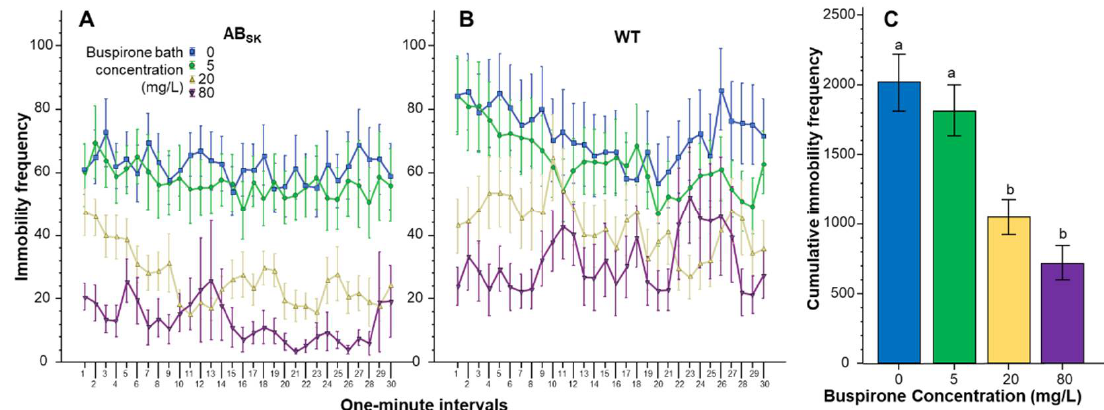
Figure 3. The number of times fish stopped moving (frequency of immobility) is dose dependently reduced by buspirone. Immobility frequency as a function of time (1-min intervals) is shown for ABSK ( A ) and WT ( B ) zebrafish. The legends show the buspirone concentrations employed (blue line with rectangle 0 mg/L, green line with circle 5 mg/L, yellow line with triangle 20 mg/L, and purple line with upside down triangle 80 mg/L). ( C ) shows the cumulative (total) number of immobility episodes for the entire 30 min recording session, pooled for the two populations, exhibited by the zebrafish exposed to the different concentrations of buspirone (indicated underneath the X axis and also by the same color coding as in ( A , B )). Means + S.E.M. are shown. The results of Tukey HSD test are shown as letters above each bar of the bar graph ( C ). Bars that do not share one letter in common represent buspirone treatment groups that are significantly ( p < 0.05) different from each other. For detailed results of statistical analyses, see Results.